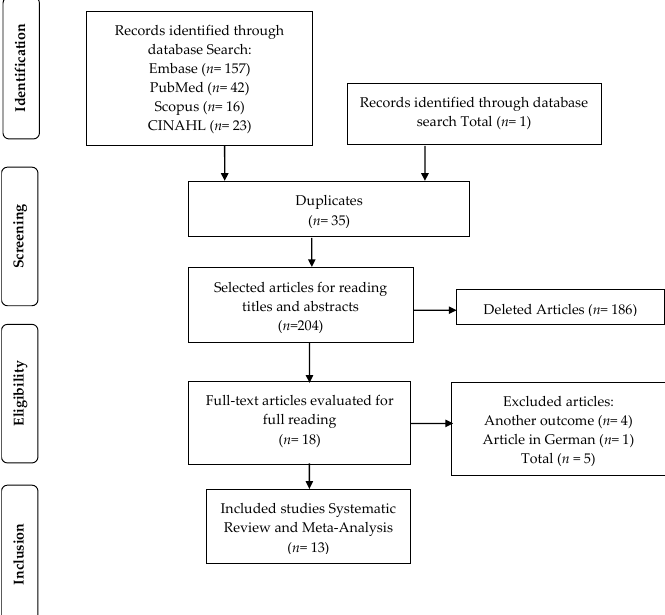
Figure 1. Flowchart of study selection.